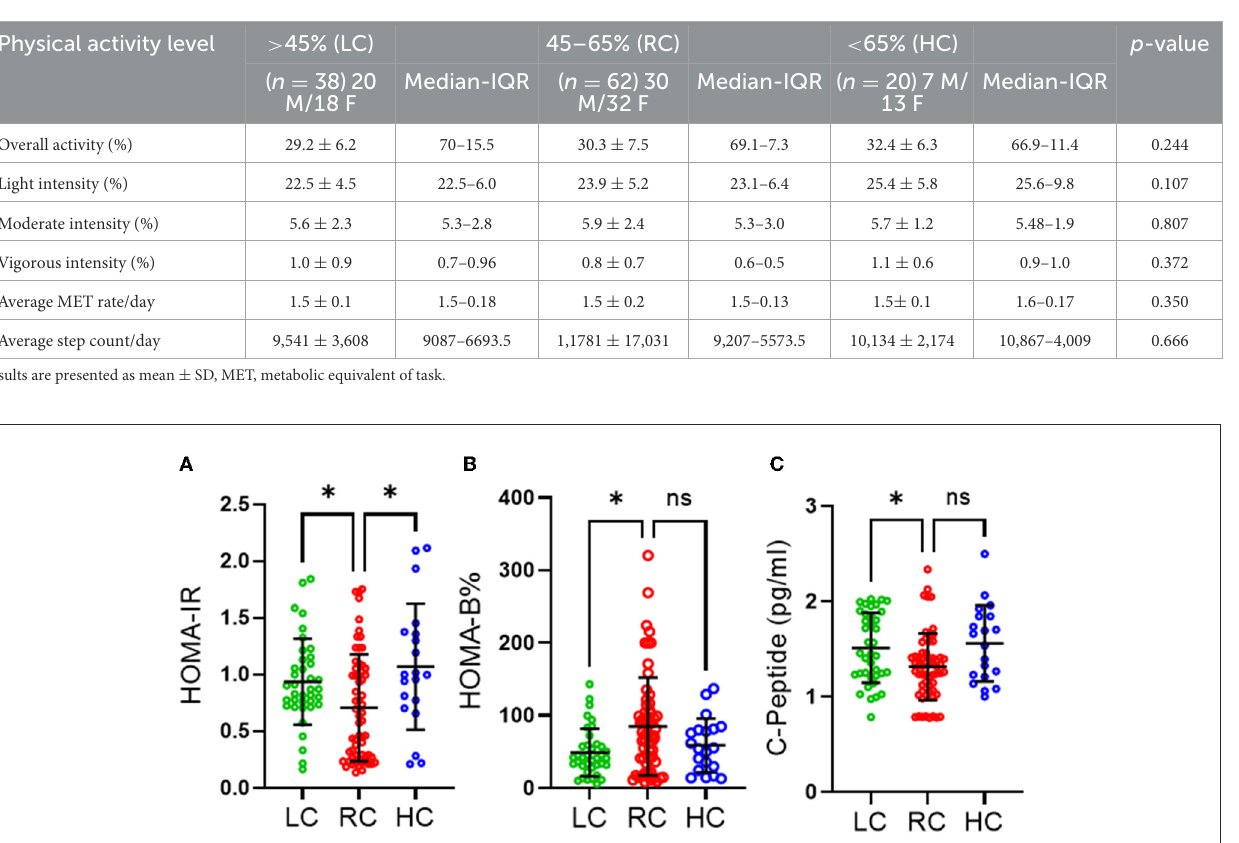
TABLE 2 Comparison of physical activity levels across groups.